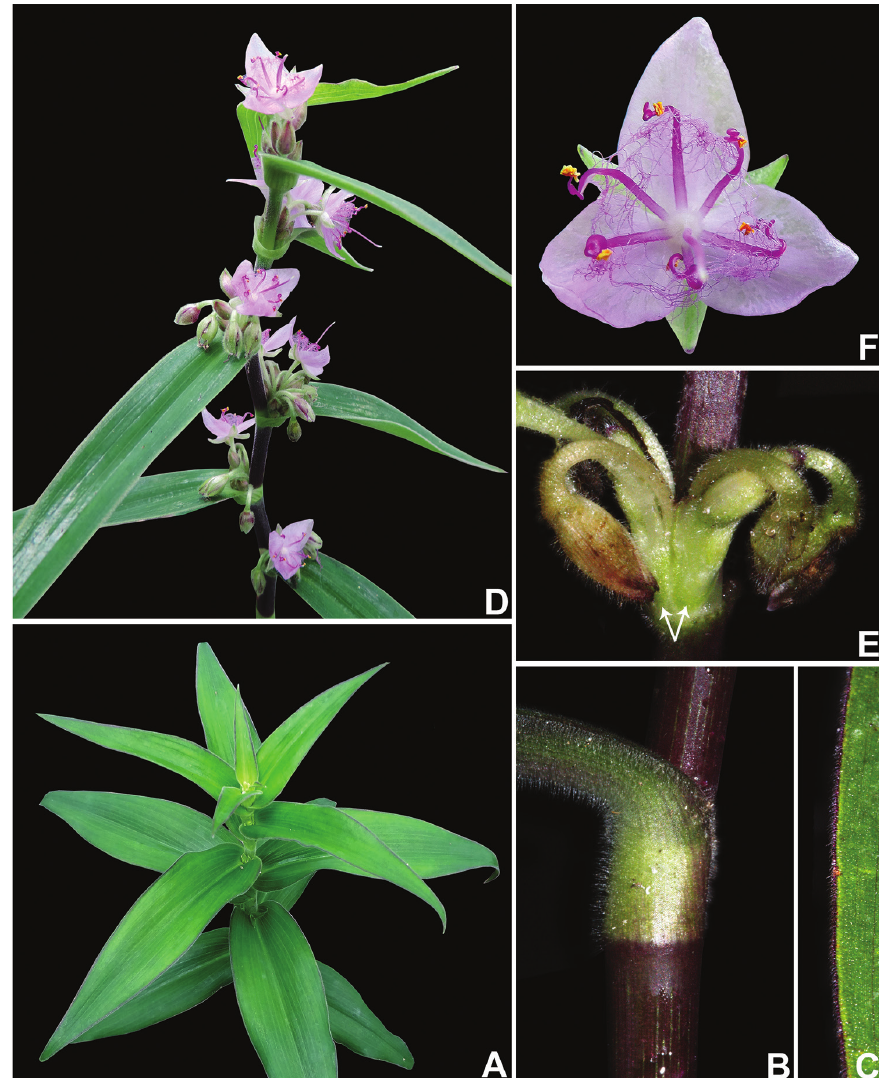
Figure 5. Tradescantia ambigua Mart. A sterile habit, showing the amplexicaulous leaf-blades B detail of the stem and leaf-sheath, showing the densely hispid leaf-sheath and blade C detail of the leaf-blade, showing the reddish, ciliate margin, and the sparsely hispid blade D fertile habit, showing the axillary, sessile inflorescences E removed leaf, exposing the sessile inflorescence and showing the reduced cincinni bracts (arrows) F post-anthesis flower, showing the apically spirally-coiled filaments. Photograph A by E.O. Moura, D & F by L.J. Leitão, B–C & E by M.O.O. Pellegrini. late, dorsally not keeled, light to medium green, rarely pink, velutine to hispid, hairs eglandular, hyaline, apex acute, margins hyaline light-green, persistent in fruit; petals 3, equal, sessile, elliptic to ovate to rhomboid, white to pale lilac to lilac to light pink